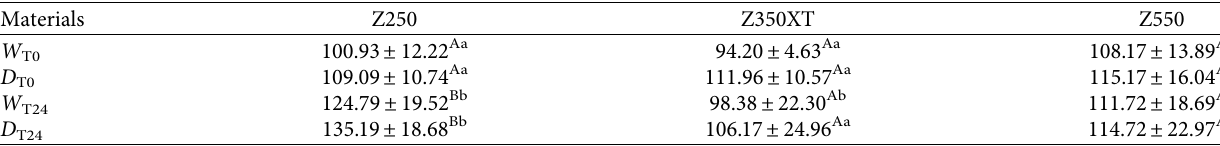
Table 3: Mean ± standard deviation (SD) values and result of comparison of fexural strength in three diferent composites in diferent polishing statuses (dry and wet) and times (0 and 24hours after). Materials